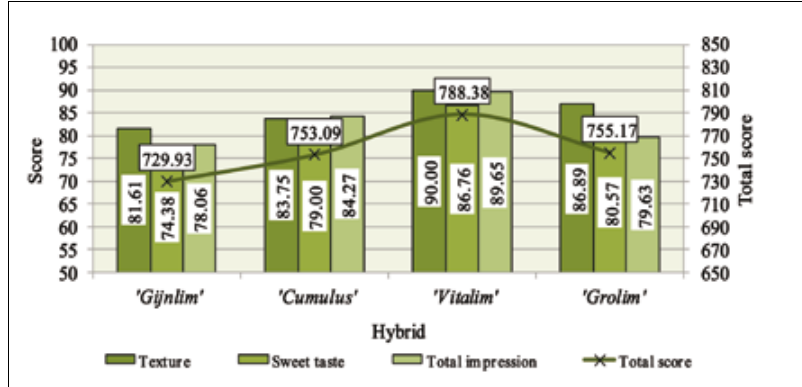
Figure 4 . Connection between the total score – texture, sweetness and total